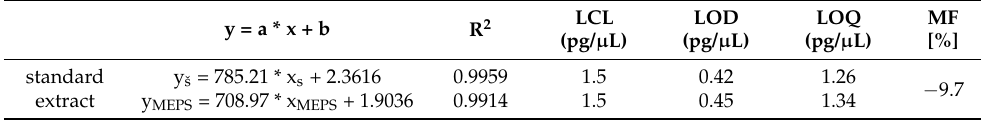
Table 2. Validation